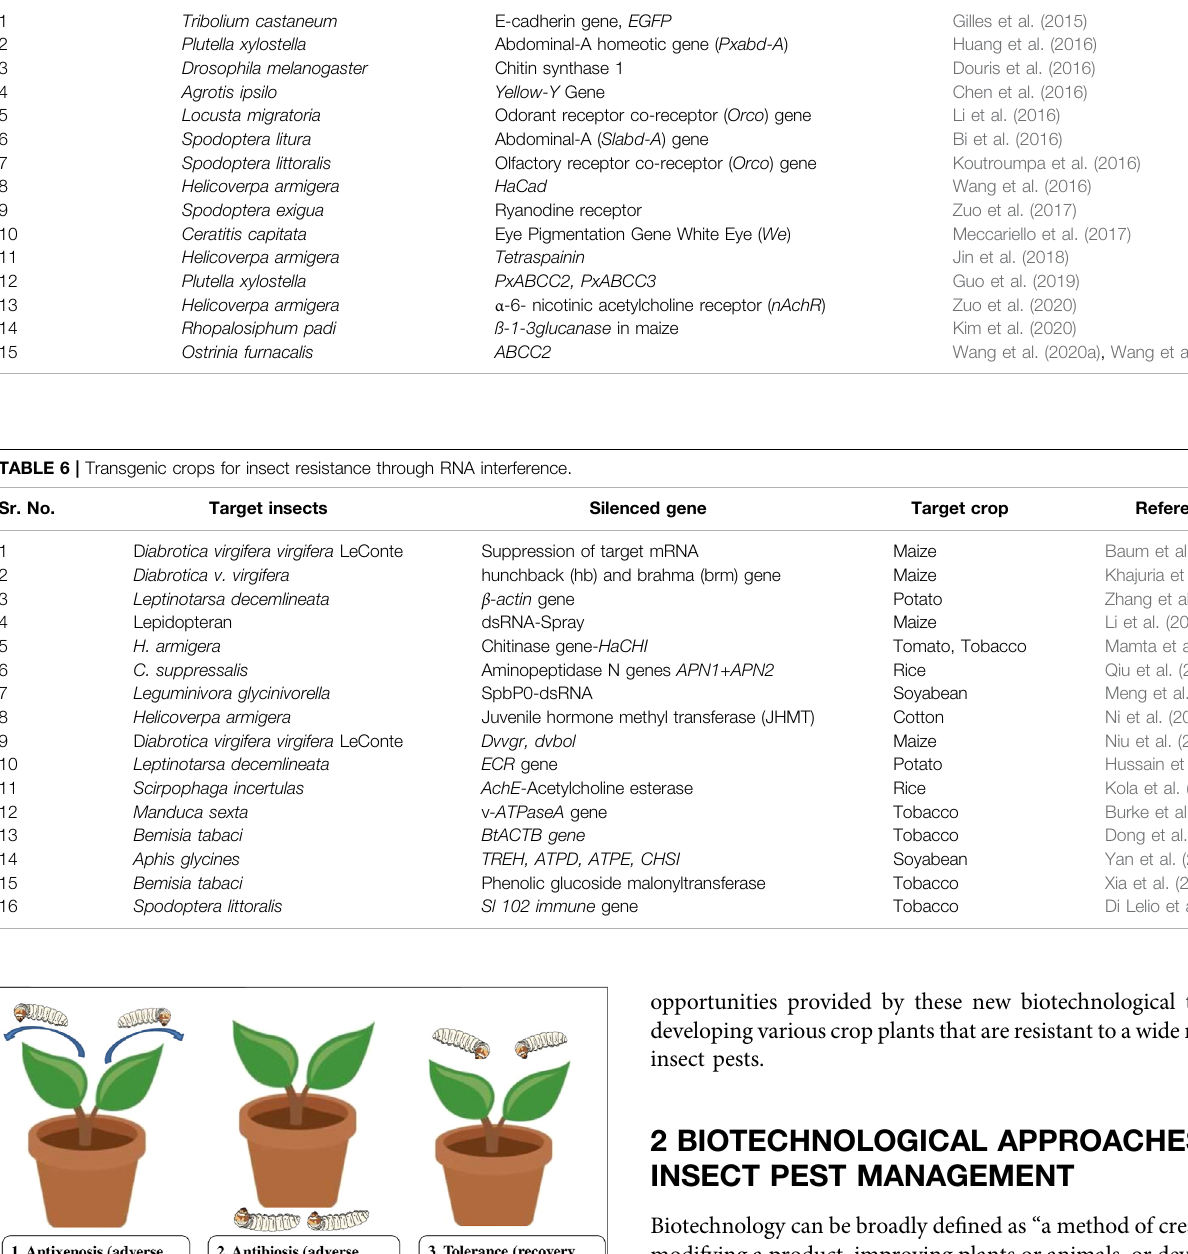
TABLE 5 | Insect engineered for pest management using CRISPR/Cas9. Sr. No.